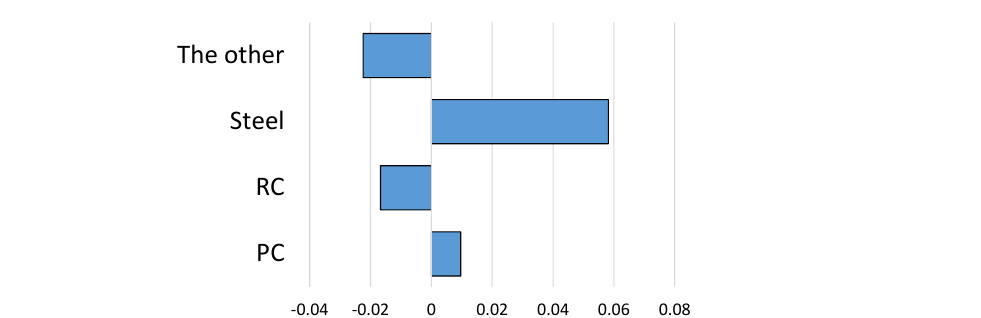
Figure 3. Range of each factor (main girders).